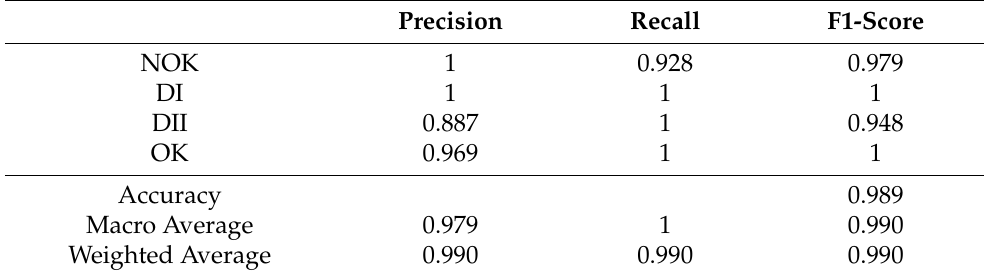
Table 7. Nissei ASB classification performance.